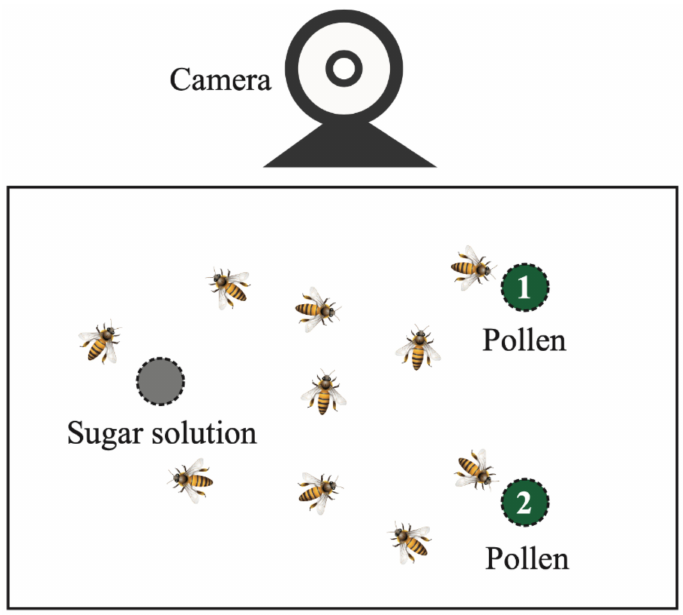
Figure 1. Schematic setup of the dual choice test of pollen diet